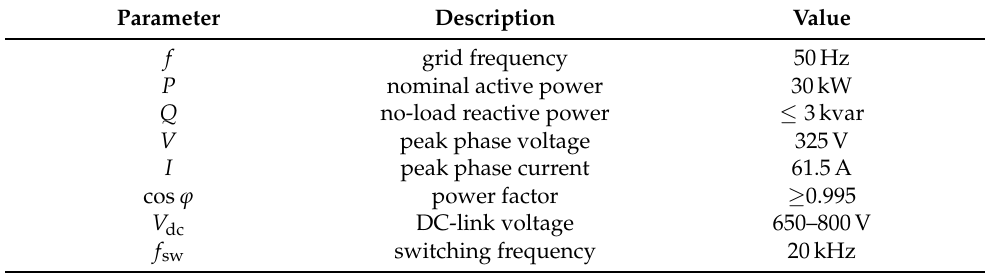
Figure 7. Schematic overview of the considered modular electric vehicle (EV) ultra-fast battery charger with highlight of the active front-end (AFE) T-type converter topology. Each of the N modules is rated at 30kW nominal active power. Table 1. Active front-end (AFE) specifications and nominal operating